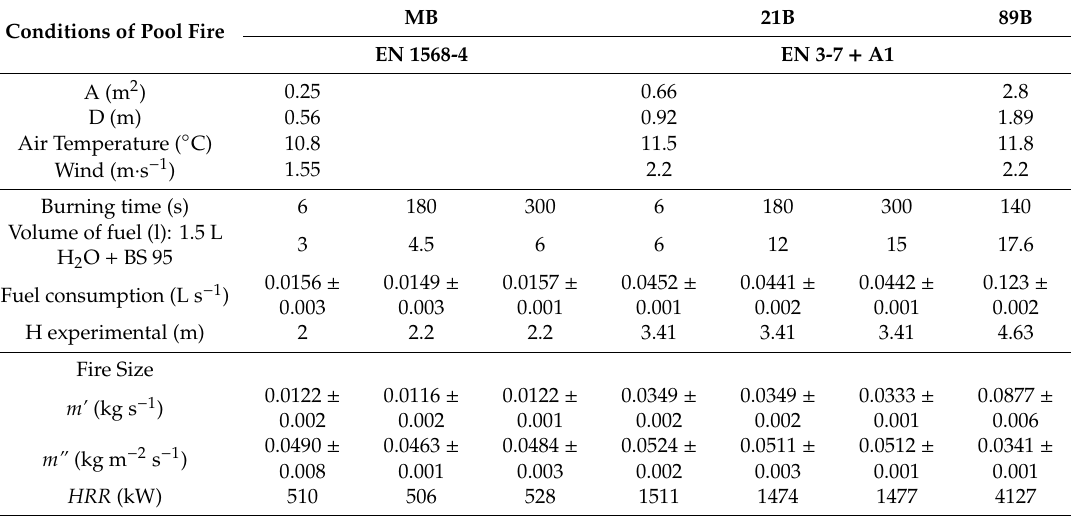
Table 2. Class B fire models, fuel, gasoline Super